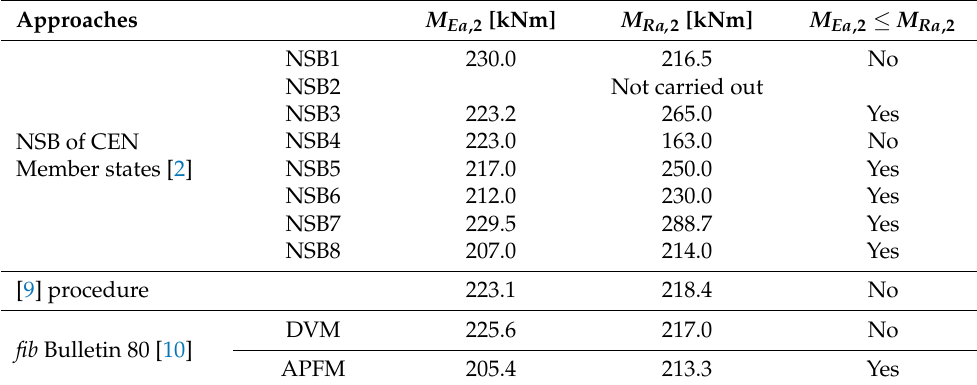
Table 11. Second stage assessment values for bending moments and